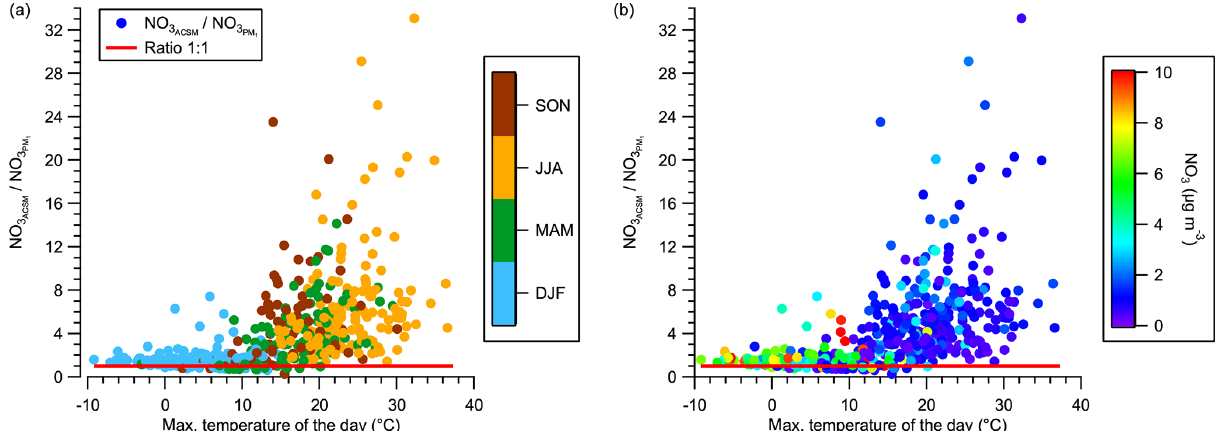
Figure 5. ACSM:PM 1 ratio nitrate mass concentration compared to the maximum temperature of the corresponding sampling day. The color code corresponds to the (a) different seasons and the (b) total nitrate mass concentration of the